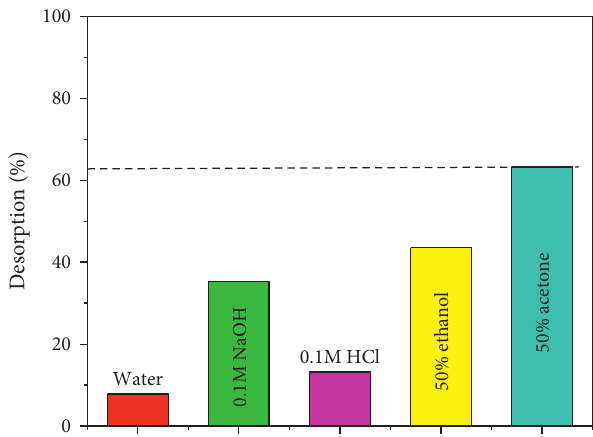
Figure 17: Desorption of RBB using different eluents.